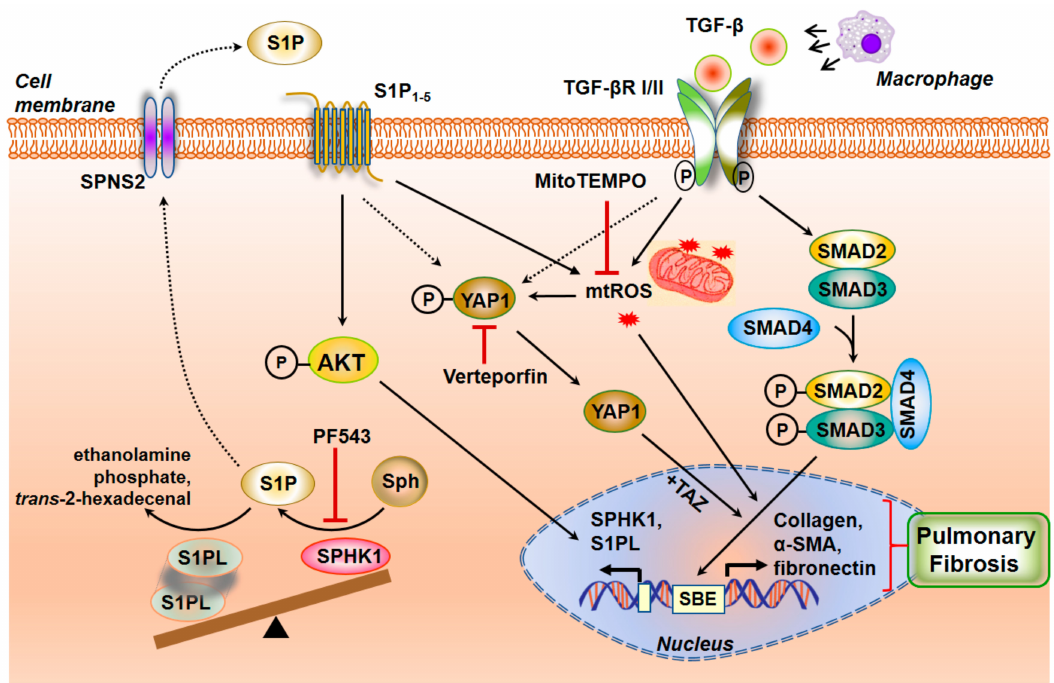
Figure 3. Crosstalk between S1P and TGF- β signaling cascade in pulmonary fibrosis. Profibrotic signaling by the inflammatory cytokine TGF- β is a ff ected through the dimerization of TGF- β 1 and TGF- β II receptors and its phosphorylation and activation of SMADs to induce a fibrogenic transcriptional